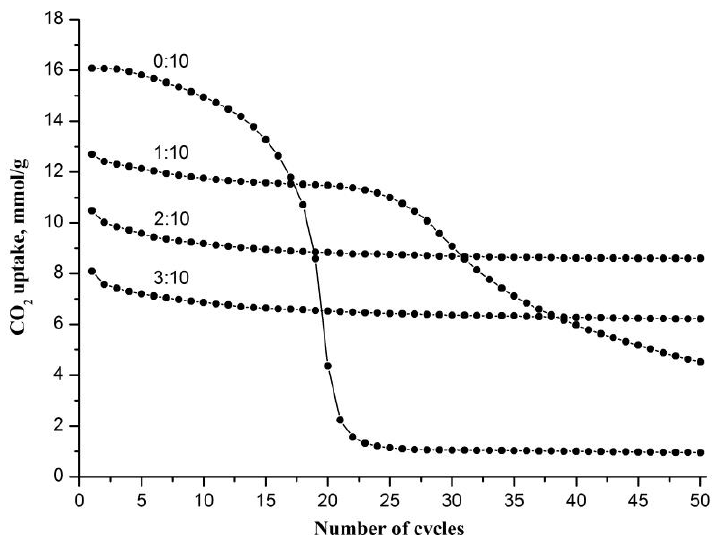
Figure 1. The dependencies of the CO 2 uptake capacity of the sorbents with different Zr/Ca molar ratios on the number of carbonation – calcination cycles.